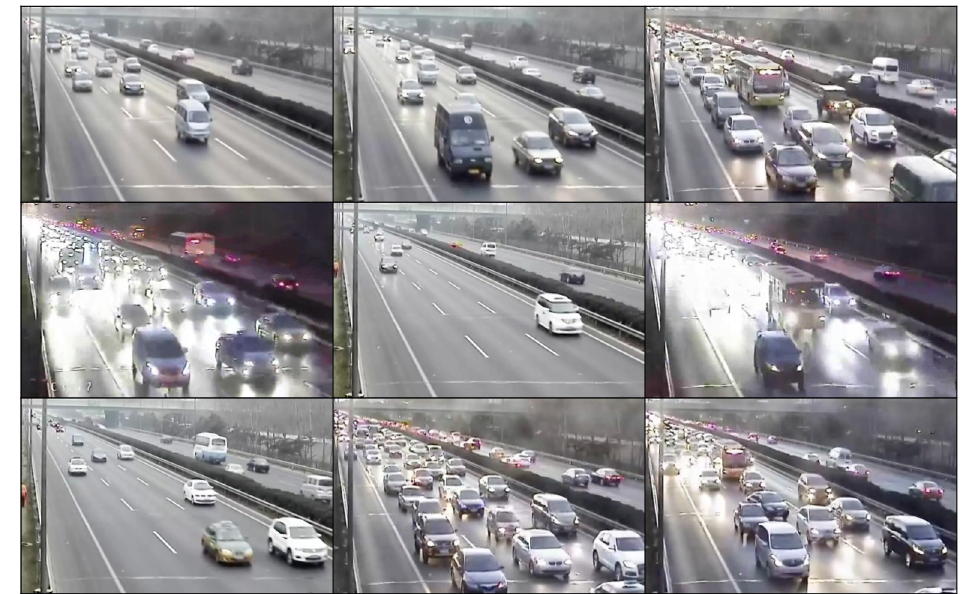
Figure 5. Surveillance video of Capital Airport